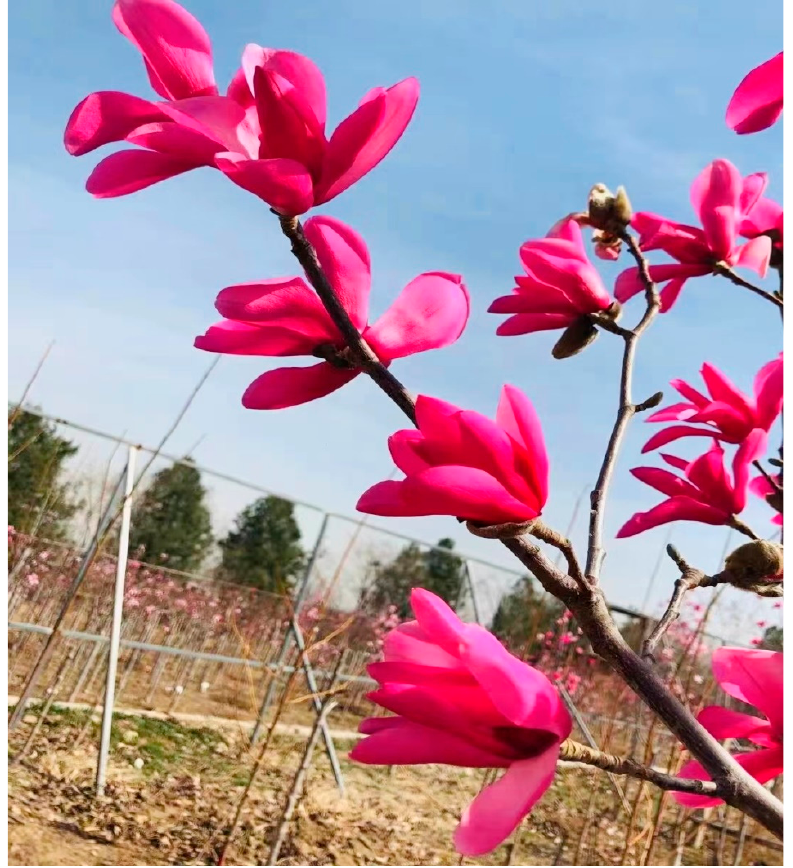
Figure 1. Magnolia wufengensis flower in Jiufeng, Beijing, China.